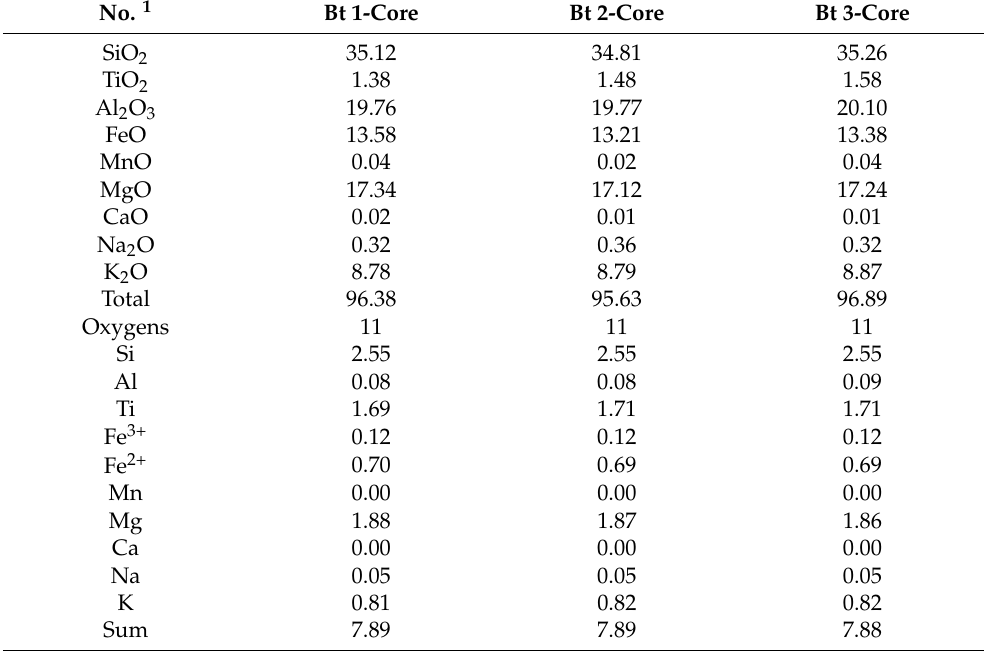
Table 3. Representative electron microprobe analyses for three biotite grains in contact with the garnet (wt.%).